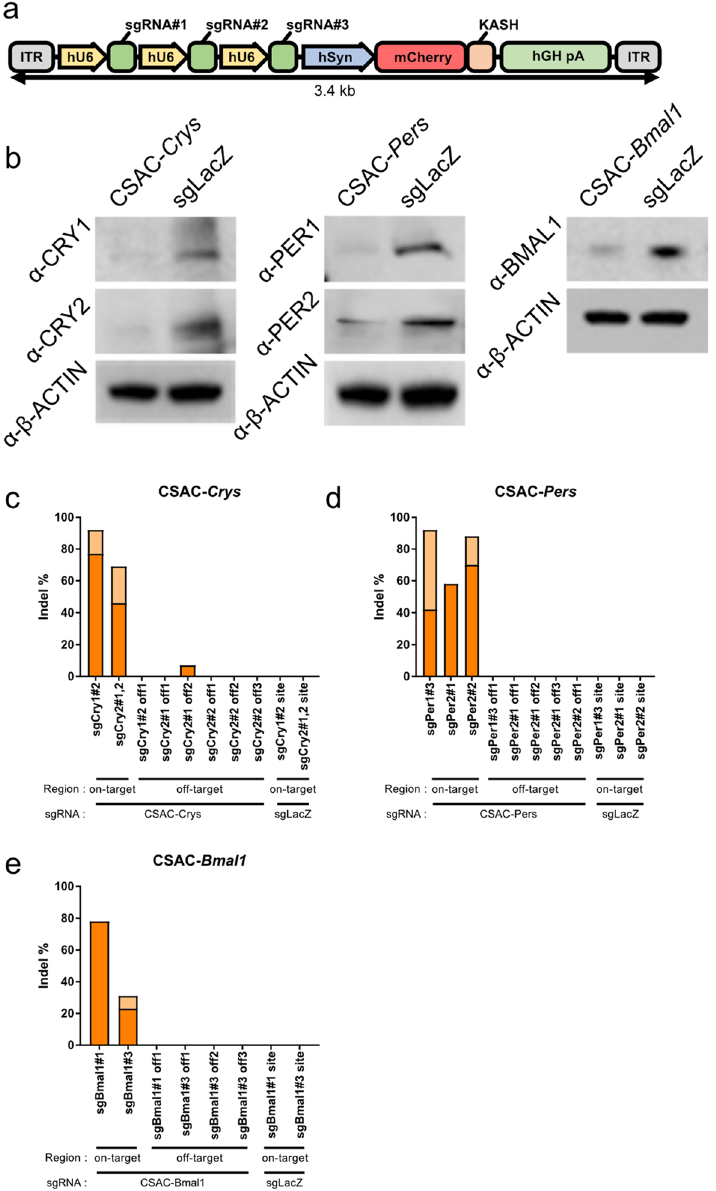
Figure 2. Reduced protein levels of core clock components by genome editing with a multiplexed sgRNA- expressing cassette. ( a ) Structure of multiplexed U6 promoter-driven sgRNA expression cassettes for AAV packaging. ( b ) Representative western blots of protein extracts from Neuro2a-Cas9 cells transfected with CSAC- Crys (left), CSAC- Pers (middle), or CSAC- Bmal1 (right). Proteins from CSAC- Crys -infected cells were probed with anti-CRY1 and anti-CRY2 antibodies. Proteins from CSAC- Pers -infected cells were probed with anti-PER1 and anti-PER2 antibodies. Proteins from CSAC- Bmal1 -infected cells were probed with anti-Bmal1 antibodies, with anti-β-actin antibodies used as an internal control for total protein abundance. ( c – e ) Percentage of indel mutation induced by CSAC- Crys ( c ), CSAC- Pers ( d ), CSAC- Bmal1 ( e ), and LacZ, respectively. On-target and off-target sites of each sgRNA included in CSAC are indicated. Orange bar: frame-shift mutation; Light orange bar: non-frame-shift